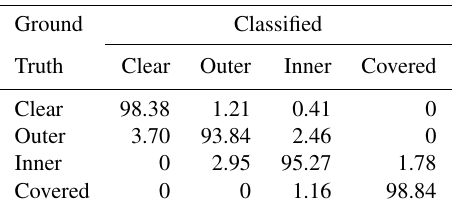
Table 5. Confusion matrix of classification result using random for- est.